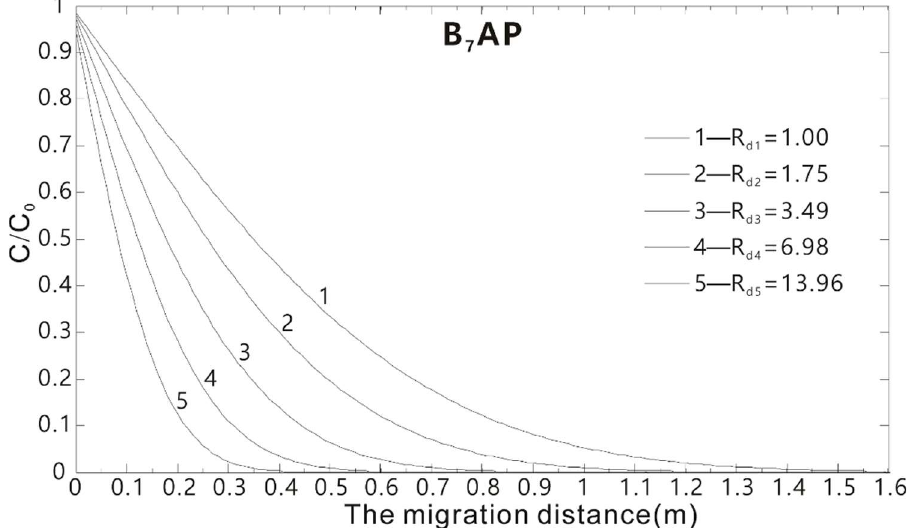
Figure 9. Effect of retardation factor on migration of uranium in B 7 AP buffer material (t = 1000 a).